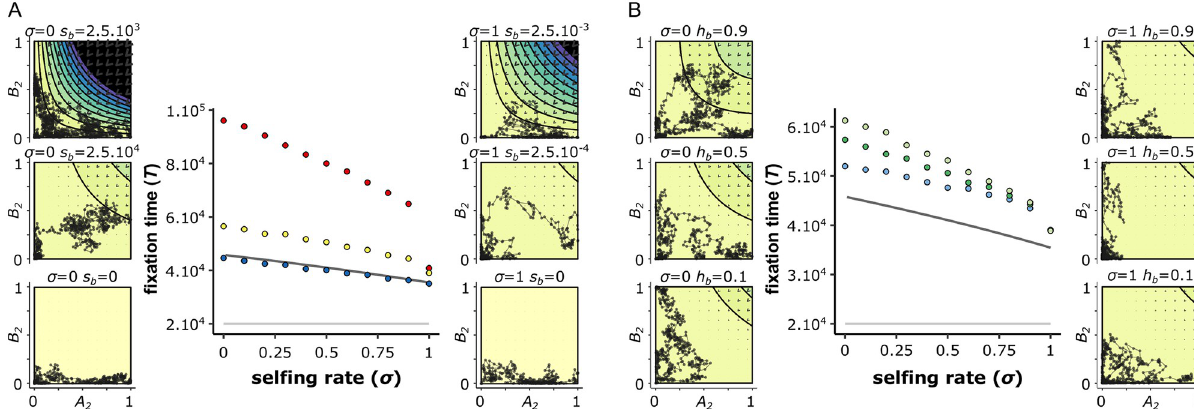
Fig 7. Within-population interferences between BDMi mutations slow down their fixation, and occur less in highly selfing populations (two- locus model). The A panel shows the fixation time of co-dominant BDMi mutations ( h = 0.5), and with a strength of selection ( s ) of either 0 (blue), b b 2.5.10 − 4 (yellow), or 2.5.10 − 3 (red). The B panel shows the fixation time of BDMi mutations with a strength of selection ( s b ) of 2.5.10 − 4 that are either recessive ( h = 0.1; light blue), co-dominant ( h = 0.5; green), or dominant ( h = 0.9; light green). The solid lines in the neutral scenario correspond to b b b analytical approximations: 1/2 μ (light grey), and Eq (17) (dark grey) (see BDMi Results section for details on the approximations). Each phase portrait shows, for a single simulation, the change in allele frequencies of A 2 and B 2 plotted from the beginning, and then every 100 generations until the fixation of a derived allele. The isoclines represent the expected benefits (warm colours) and costs (cold colours) on population fitness (multiplied by N e , and with a increment of 1). The direction of the arrow indicates the expected allele change (which is the balance between mutation rates and selection), and their size indicates the strength of the change. N = 10, 000, k = h , s = 0, r = 0.5. 10, 000 iterations. b b